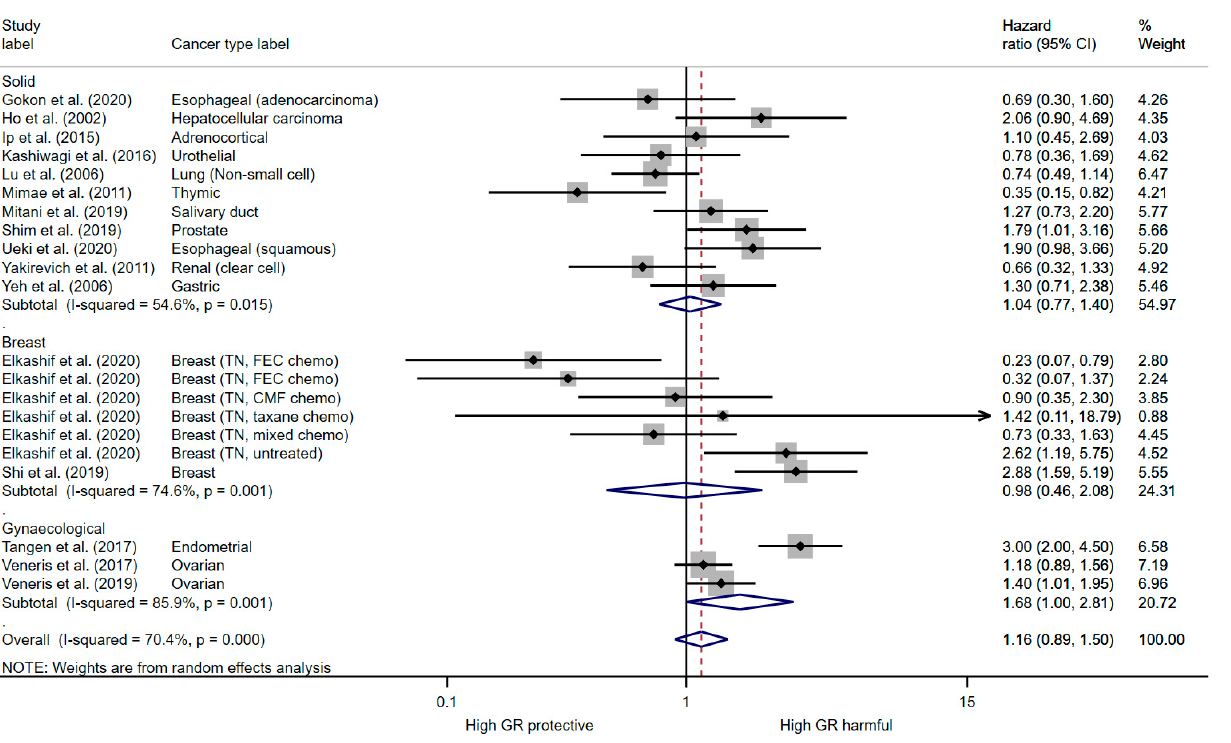
Figure 3. The forest plot for univariate overall survival and glucocorticoid expression ( n = 2814). The meta analysis was preformed using hazard ratio and 95% confidence intervals (random effects). The chi-squared ( χ 2) for heterogeneity was performed and the proportion of variance between effect estimates is represented by I 2 , with a level of >50% considered significant.